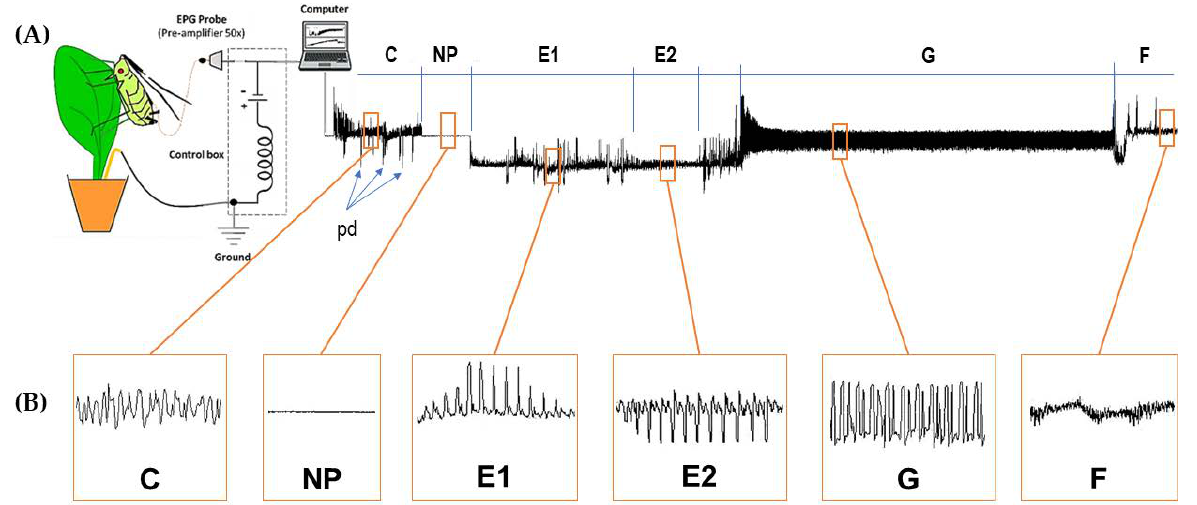
Figure 3. Analysis of aphid feeding behaviour by electropenetrography. ( A ) EPG system set-up with waveform pattern; ( B ) typical waveforms corresponding to different feeding phases; C: intercellular stylet pathway and salivation; pd: potential drop; E1: salivation into phloem; E2: passive phloem sap uptake; G: active intake of xylem sap; F: stylet penetration